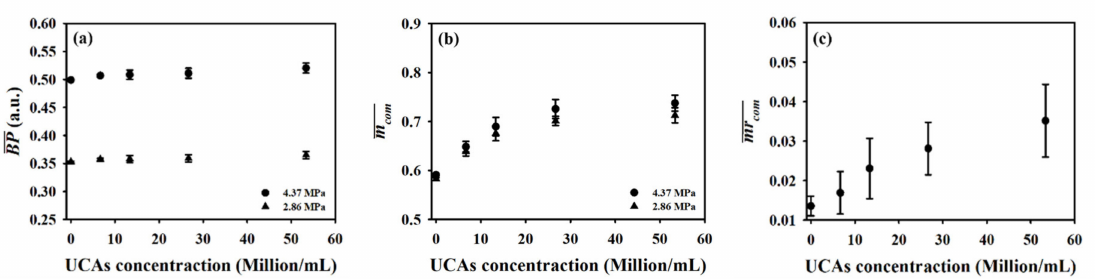
Figure 8. Average ( a ) backscattered power, ( b ) window-modulated compounding (WMC) Nakagami parameter, and ( c ) WMC Nakagami parameter ratio parameter as a function of UCAs